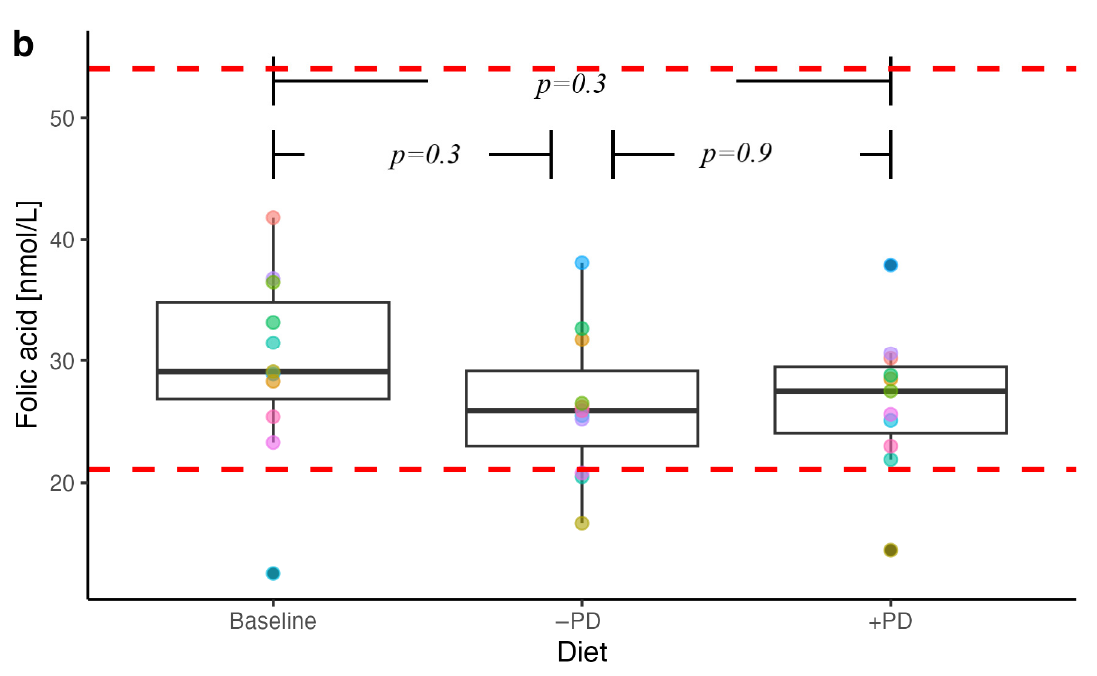
Figure 4. Serum B-vitamin concentrations in privately owned healthy adult dogs (n = 11) fed a commercial diet with (+PD) or without ( − PD) Enterococcus faecium NCIMB 10415 10 9 CFU/kg for 16 days each in a crossover study design compared to baseline concentrations at inclusion. Each dot colour on the plot identifies the individual dog across diets. Red dotted lines represent laboratory reference ranges. p values < 0.05 were considered significant.